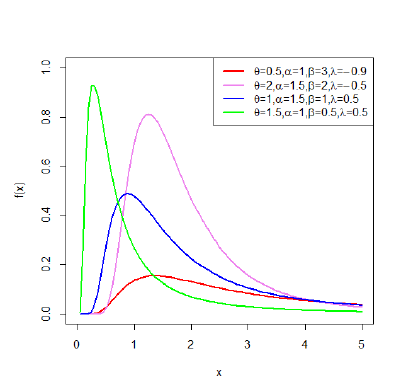
Figure 1 – Plot of the pdf of ETF distribution for given parameter values.